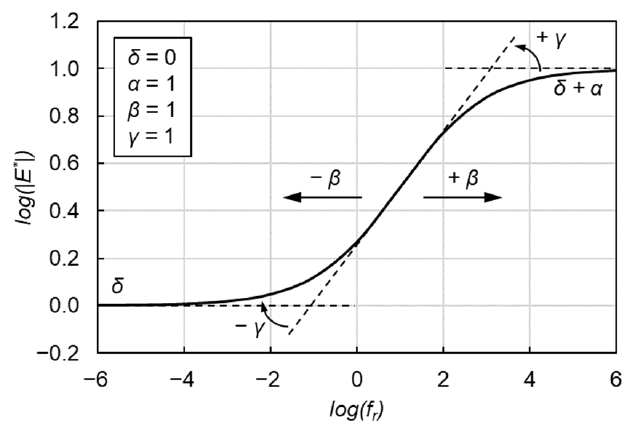
Figure 2. Graphical interpretation of SLS model.